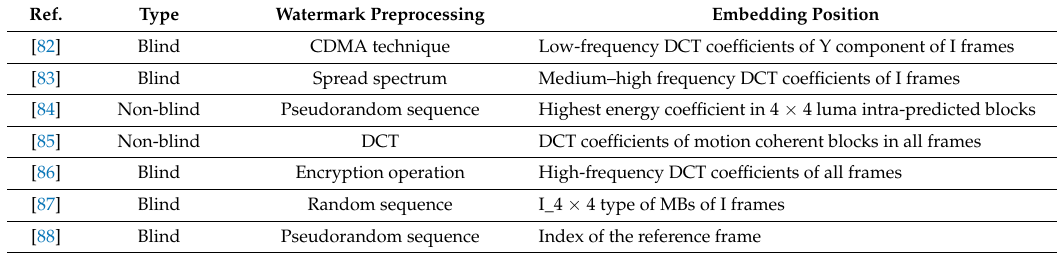
Table 10. Summary comparison of several H.264-based watermarking algorithms.